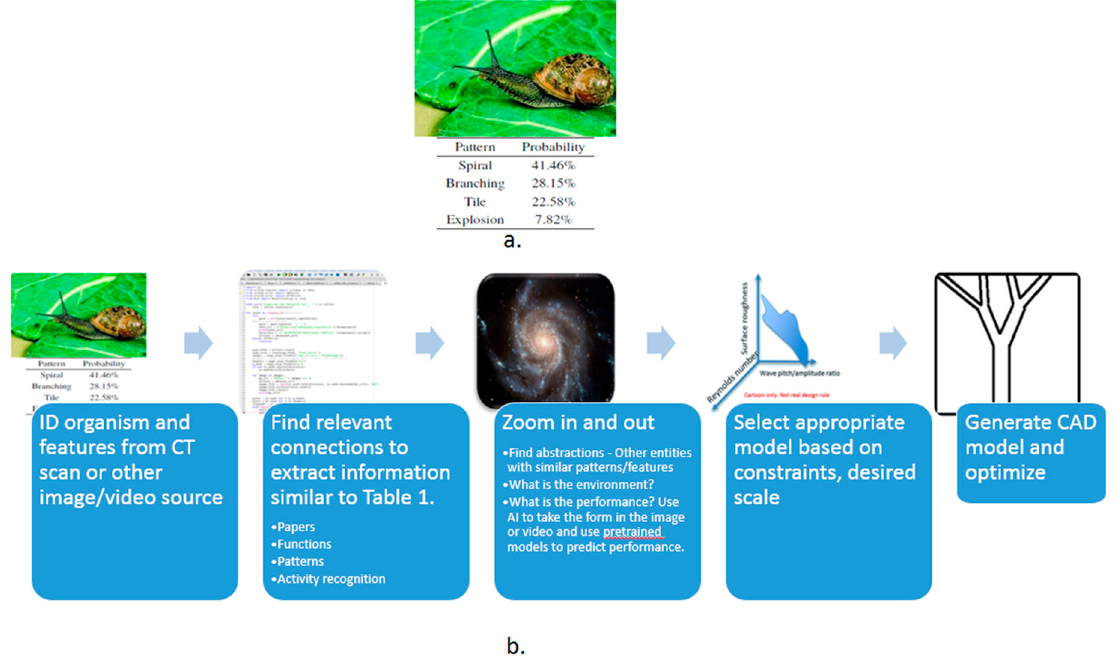
Figure 6. ( a ) Example of pattern distribution for an organism. It can be inferred that the organism system, as a whole, is geared toward structural integrity due to the predominance of the spiral and tile pattern in the composition. Spirals are associated with distribution of stress, fluid and energy. Tiles or lattices or tessellations are structural patterns. ( b ) Role of computer vision in discovery.